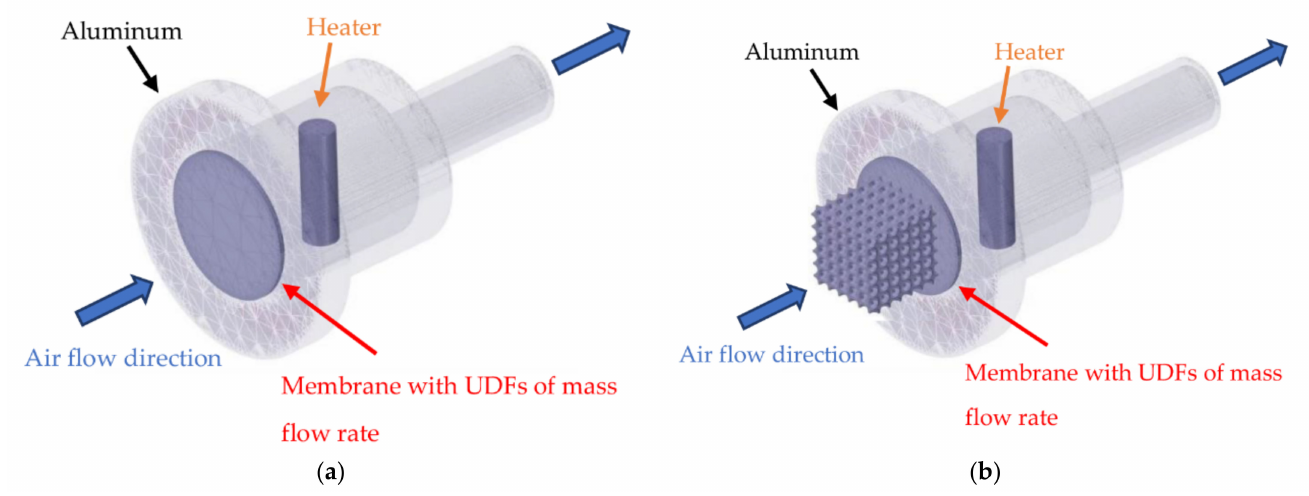
Figure 4. Simulation models of thermal transpiration membrane: ( a ) without TPMS geometry; ( b ) with TPMS